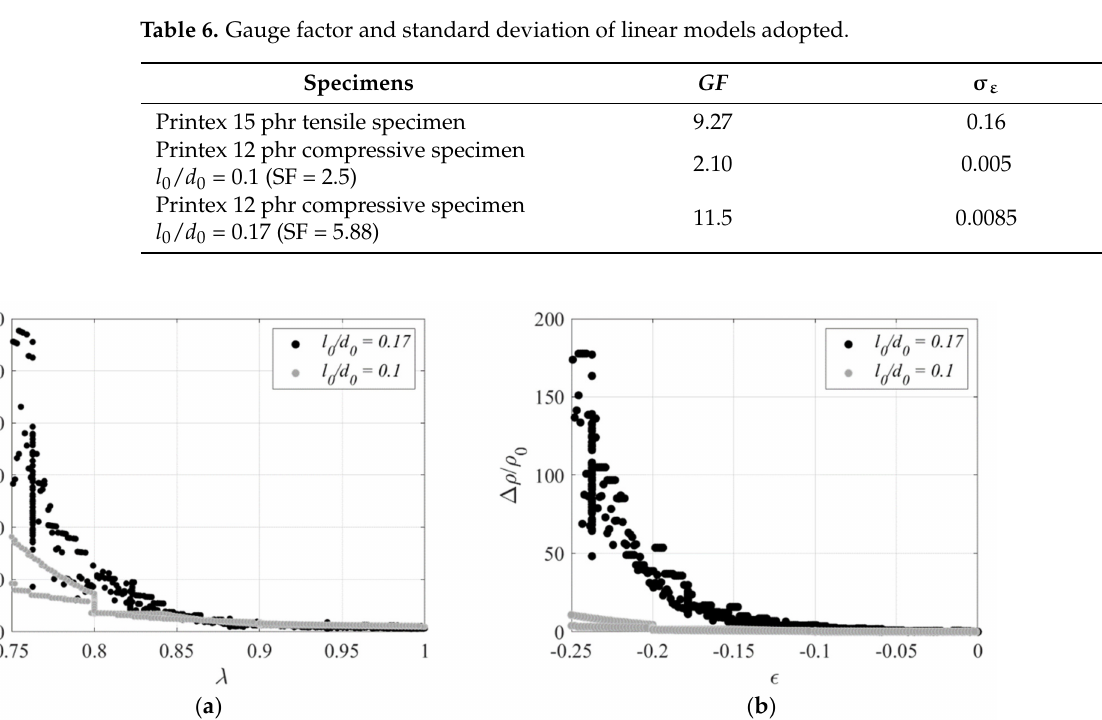
Figure 34. Effect of the shape factor: ( a ) Resistivity vs. compressive strain, ( b ) Normalised resistivity change vs. compressive strain.